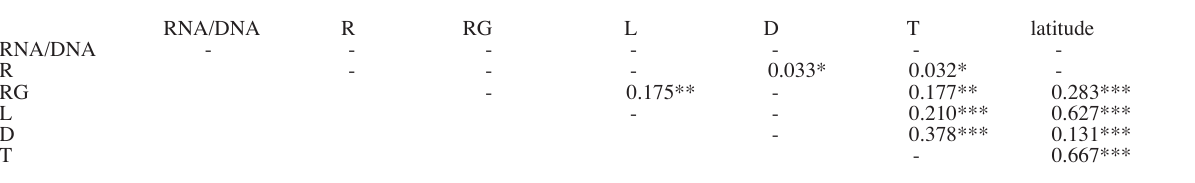
T ABLE 3. – Correlation coefficients between RNA/DNA ratios, R condition factor (mg), RG recent growth index (mean width of the last 10- day increments (µm)), L total length (cm) and D density (ind/10000 m 2 ) of total 0-group juvenile sole catches computed from the survey, T bottom temperature (°C) and